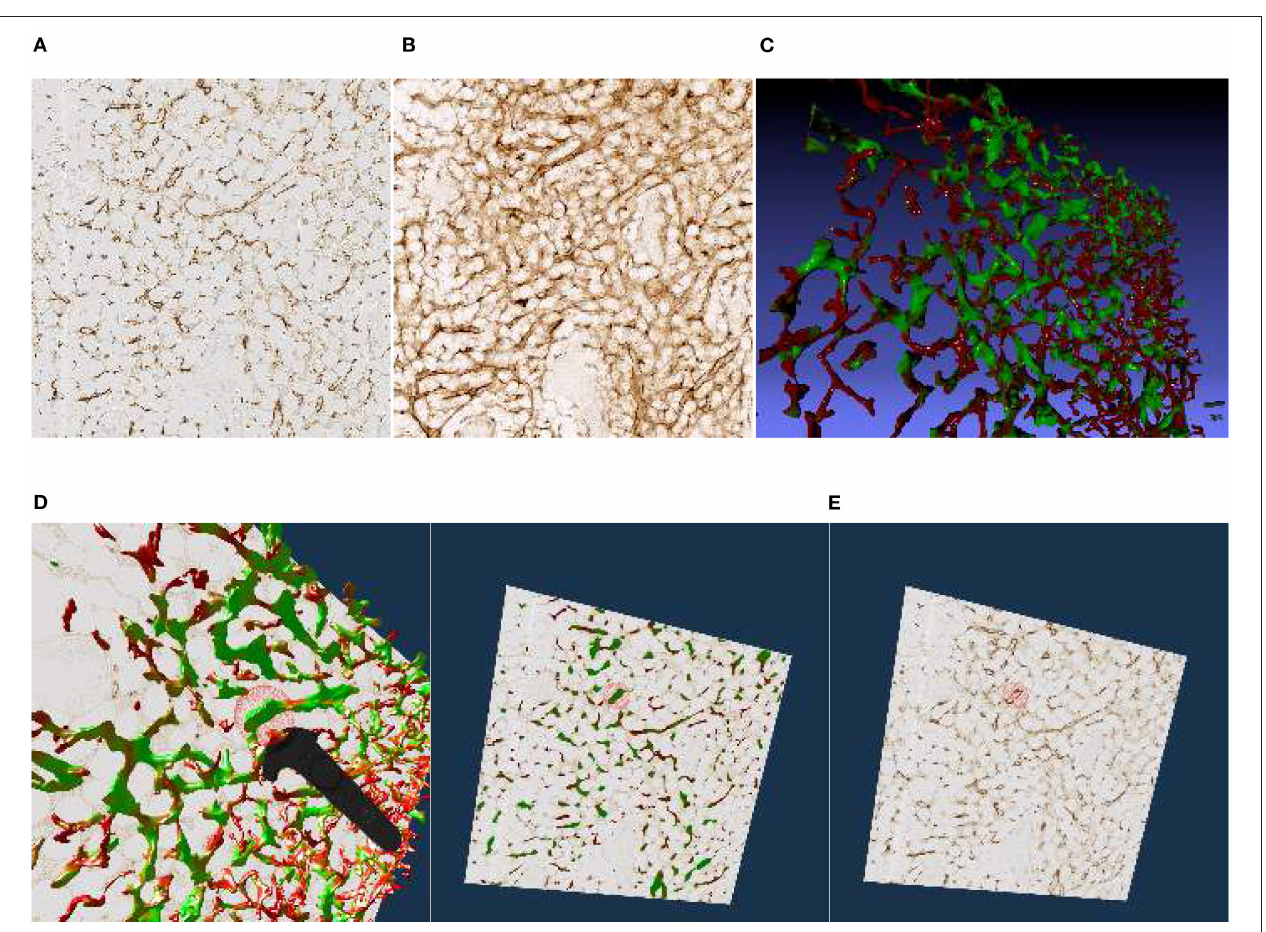
FIGURE 4 | Images, renderings, and VR screenshots showing mesh reconstructions of blood vessels in a human bone marrow specimen, stained with anti-CD34 plus anti-CD141. (A) A single section. The staining color is brown for both molecules in the original data. (B) A volume rendering of 21 consecutive serial sections. (C) The reconstructed mesh. It shows shape diameter function values, color-coded from red to green. (D) We annotate a position of interest in the mesh in VR. An original section is seen in the background. (E) We have found the section containing the annotation, the mesh is still visible. (F) Only the section with the annotation is shown in VR. Domain experts can now reason on the stained tissue at the marked